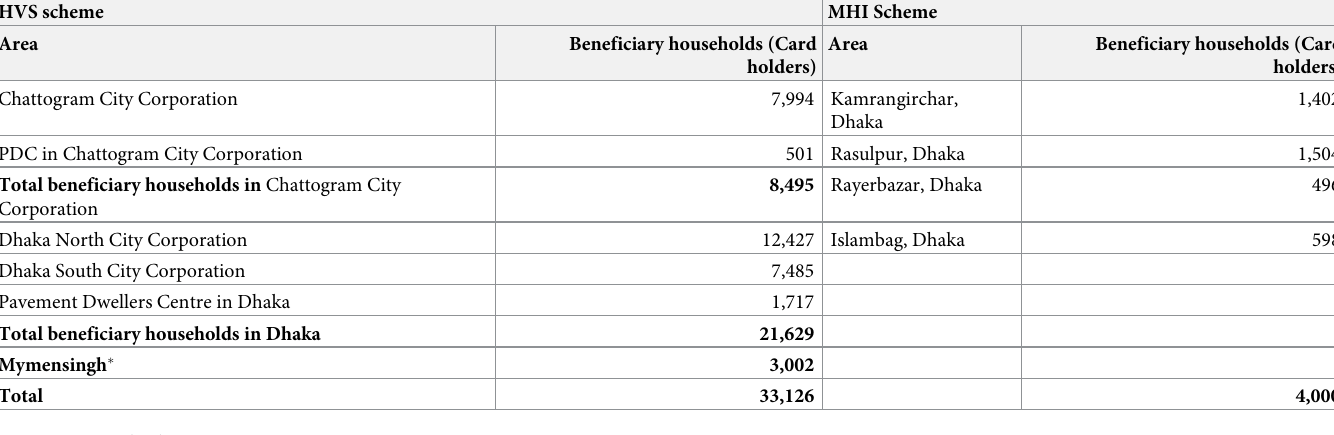
Table 2. Number of cards from Health Voucher Scheme (HVS) and Micro Health Insurance (MHI) schemes distributed to households in different areas in Bangladesh. HVS